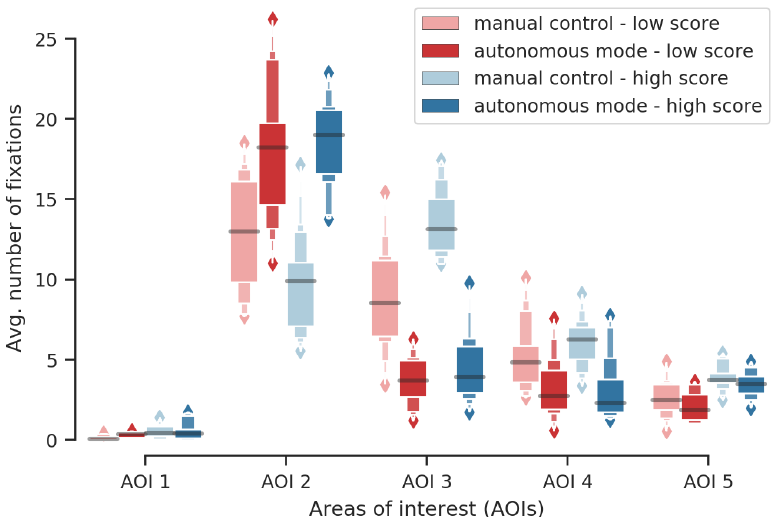
Figure 7. Average number of fixations on AOIs during autonomous mode and manual control, given the performance group. AOI 1: remaining time; AOI 2: external tank; AOI 3: robot video stream; AOI 4: map; and AOI 5: robot’s